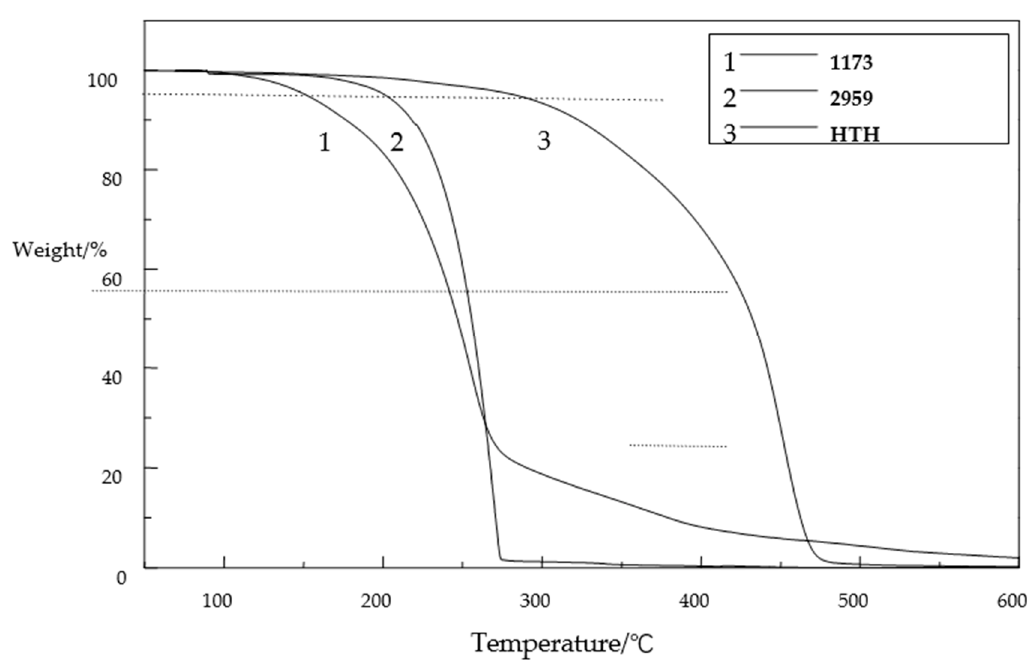
Figure 7. TG spectrum of 1173, 2959, and HTH.